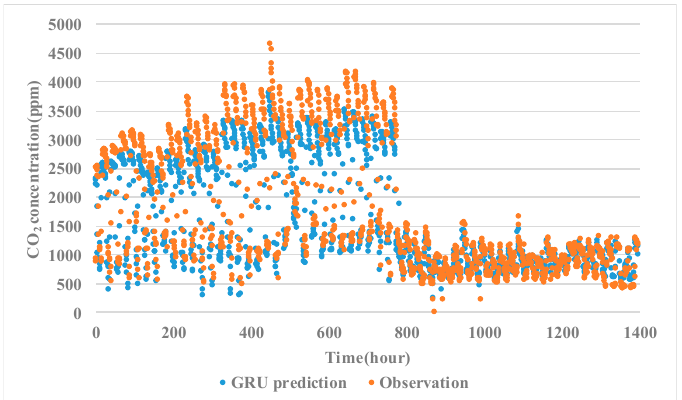
Figure 7. Scatter plot of GRU model. Note: The data on the left are autumn and winter, the data on the right are spring and summer.